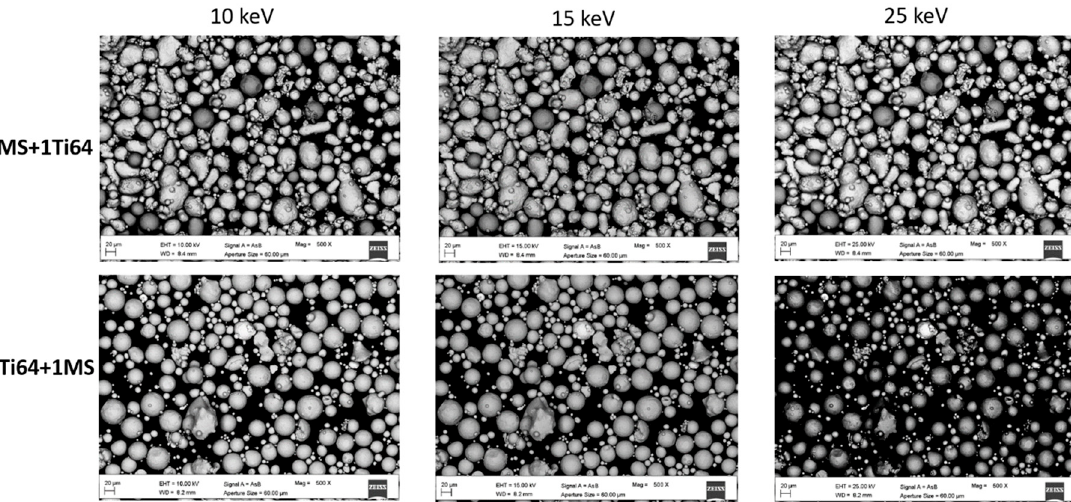
Figure 1. Comparison of micrographs taken at different values of accelerating voltage, for two cross-contamination samples, MS + 1Ti64 (upper row) and Ti64 + 1MS (lower row).